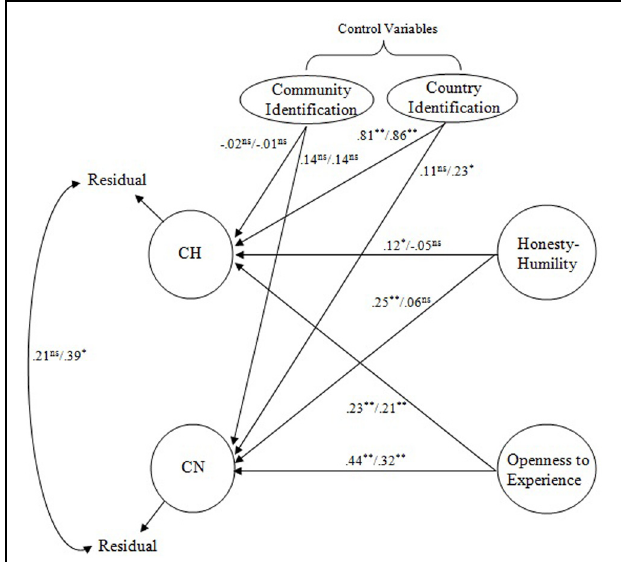
FIGURE 1 | A Saturated Model of CH, CN, Honesty–Humility and Openness to Experience. CH, Connectedness to Humanity; CN, Connectedness to Nature; H, Honesty–Humility, O, Openness to Experience. Values on the left (right) side were standardized coefficients obtained from the model involving self-reported (observer reported) personality. ∗ p < 0.05, ∗∗ p <